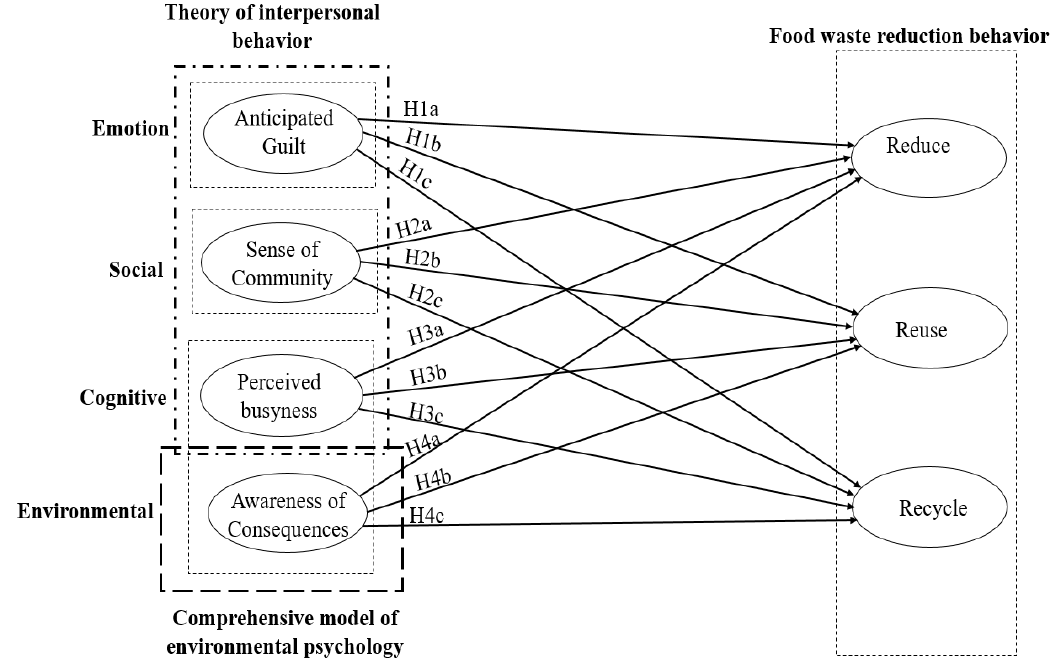
Figure 1. Conceptual Model of Food Waste Reduction Behavior.